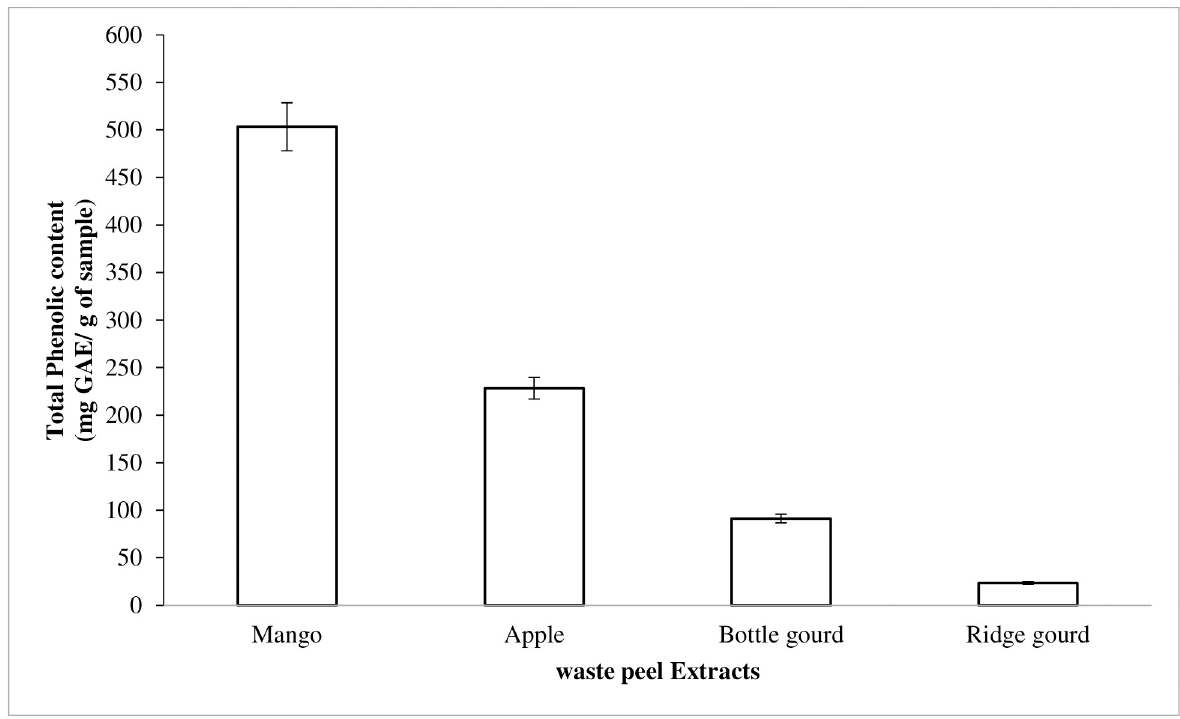
Fig 2. Total phenolic content in fruit and vegetable peel